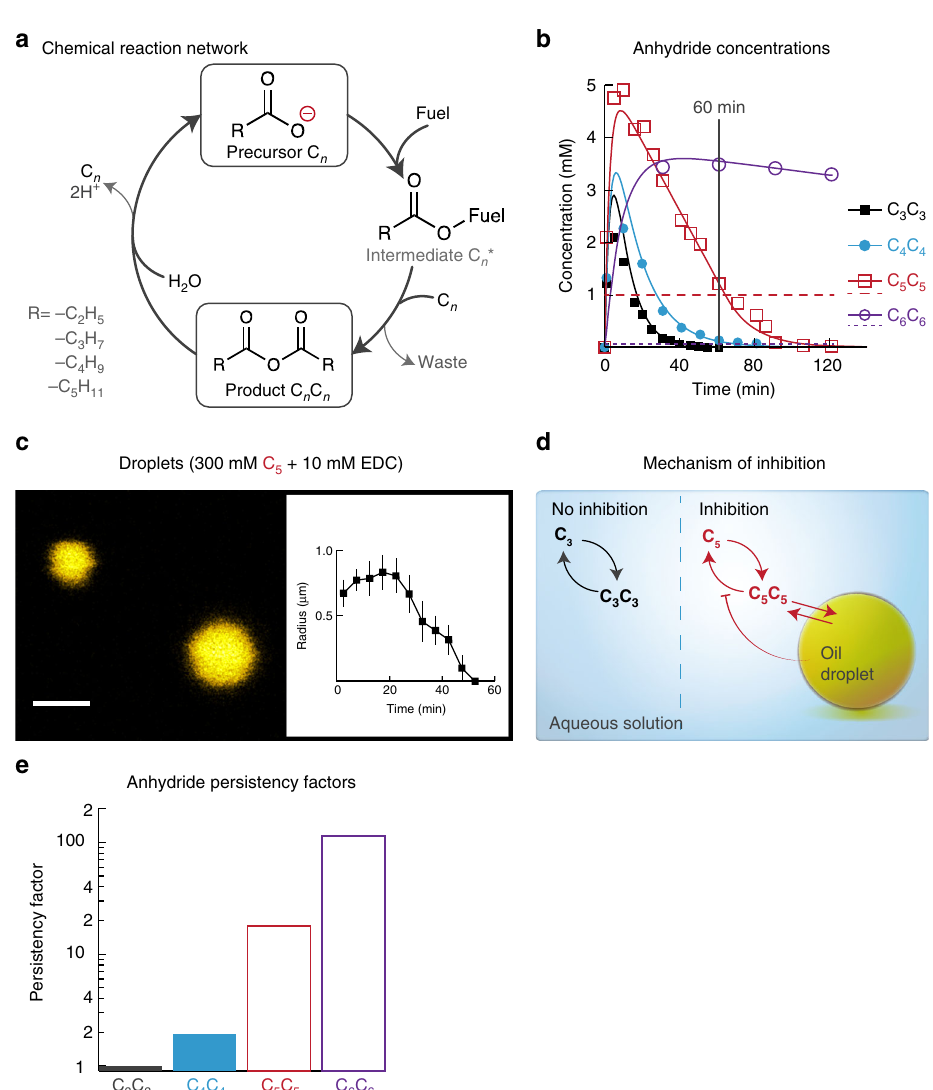
Fig. 1 Phase-separation into anhydride-droplets inhibits anhydride hydrolysis. a Chemical reaction network that drives the formation of phase-separating products. Linear saturated aliphatic carboxylic acid precursors (C n ) are activated by high-energy condensing agents (fuel). The activated intermediate (C n *) can react with a second precursor molecule to form an anhydride product (C n C n ). The network operates in water and the product thus rapidly hydrolyzes to the original precursor. b Concentration of the corresponding anhydrides when 300 mM C 3 (black), 300 mM C 4 (blue), 300 mM C 5 (red), or 100 mM C 6 (purple) was subjected to 10 mM EDC. Markers represent HPLC data; solid lines represent data calculated by the kinetic model. Note the linear decay of the anhydride when the concentration anhydride is above its solubility. Horizontal dashed lines represent C 5 C 5 (red) and C 6 C 6 (purple) solubilities. c Confocal micrograph of 300 mM C 5 with 10 mM EDC after 15 min. Scale bar represents 2 µ m. The inset shows the average droplet radii against time for 300 mM C 5 with 10 mM EDC. The solution was imaged every minute. Data of 5 min was binned for statistical analysis. Error bars refer to the standard deviation between experiments ( n = 3). d Schematic representation of the mechanism of inhibition of the hydrolysis by droplets. C 3 C 3 is well soluble and rapidly hydrolyzes. C 5 C 5 is not well soluble and phase-separates into droplets. The phase-separated anhydride is not accessible to the H 2 O required for hydrolysis. Hydrolysis thus only occurs to anhydride in solution, which concentration equals the anhydride solubility. e Persistency factor against carbon number. The factor is calculated by the anhydride hydrolysis rate in the absence of droplets divided the anhydride hydrolysis rate in the presence